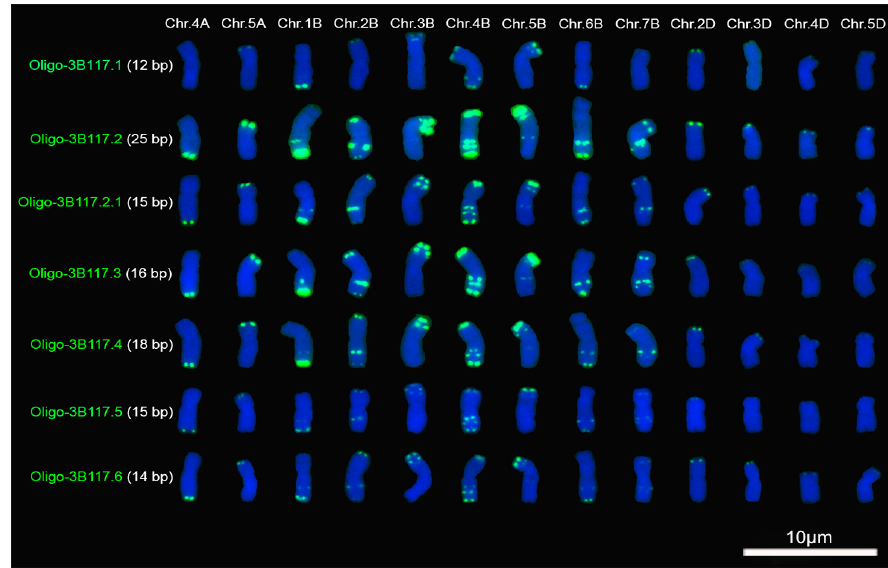
Figure 2. Signal patterns of the seven oligonucleotide probes ( green ) derived from 3B117 on the root tip metaphase chromosomes of common wheat Chinese Spring. Chr.: chromosome. Chromosomes